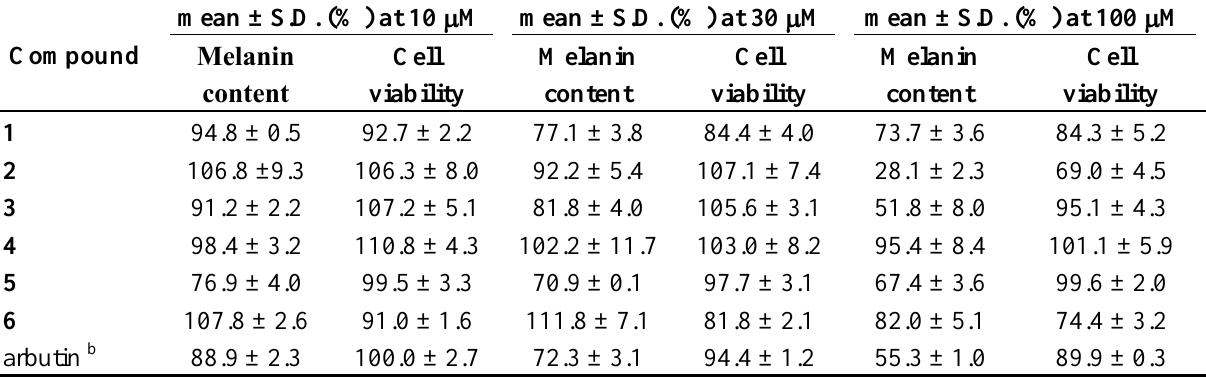
Table 2. Melanogenesis inhibitory activity and cytotoxicity in B16 mouse melanoma cells of multiflorane-type triterpenes isolated from Cucurbita maxima seeds a